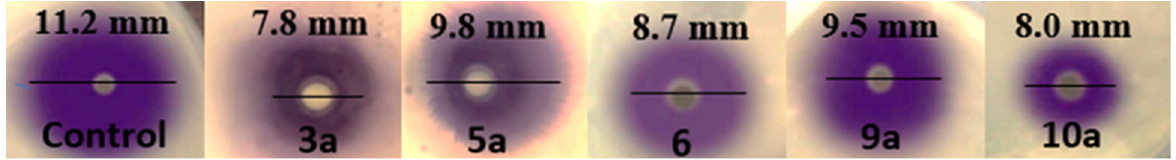
Figure 7. SDS-polyacrylamide gel electrophoresis of h CA-I and h CA-II purified by Se-pharose-4B- L-tyrosine-sulfanilamide affinity gel chromatography (Lanes 1 and 2 are for h CA-I; and Lanes 3 and 4 are for h CA-II). Table 3. Affinity chromatography purification scheme for the human erythrocyte carbonic anhy- drase-I and -II isoenzymes. Purification Step